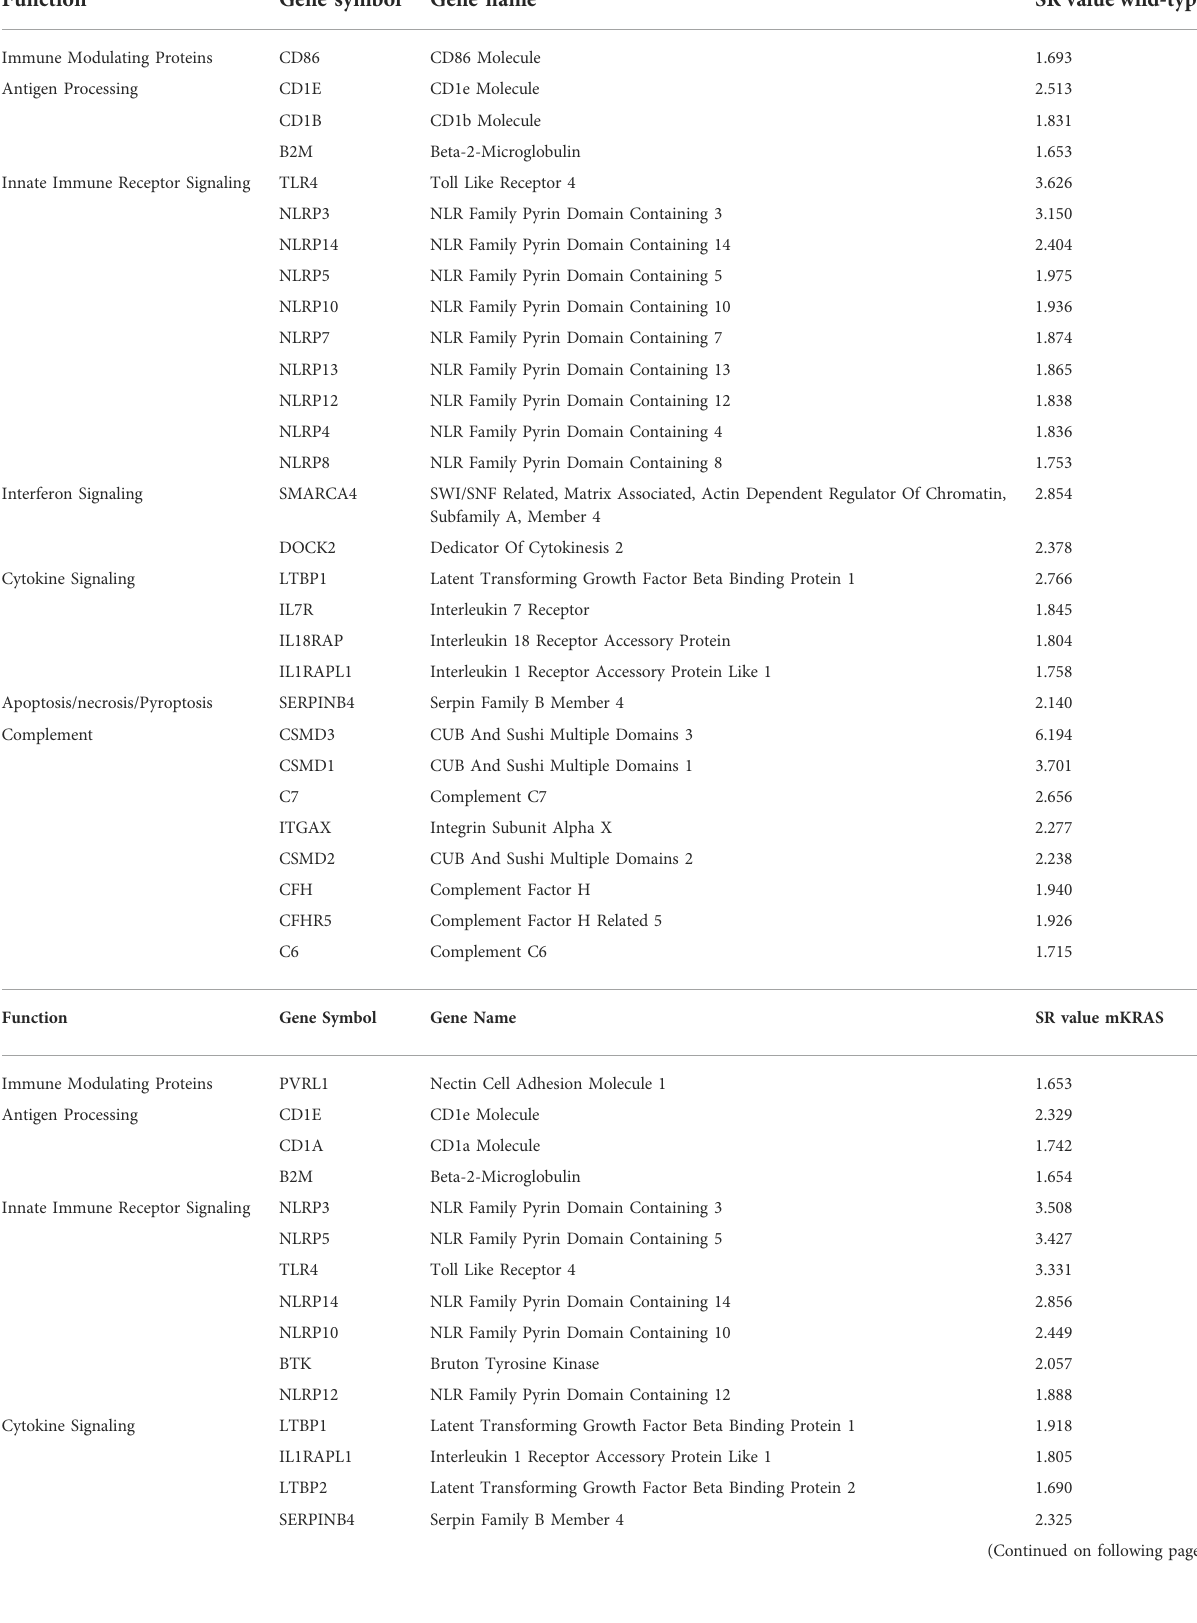
TABLE 2 Over-mutated genes in WT (top) and mKRAS (bottom) cohorts. SR ≤